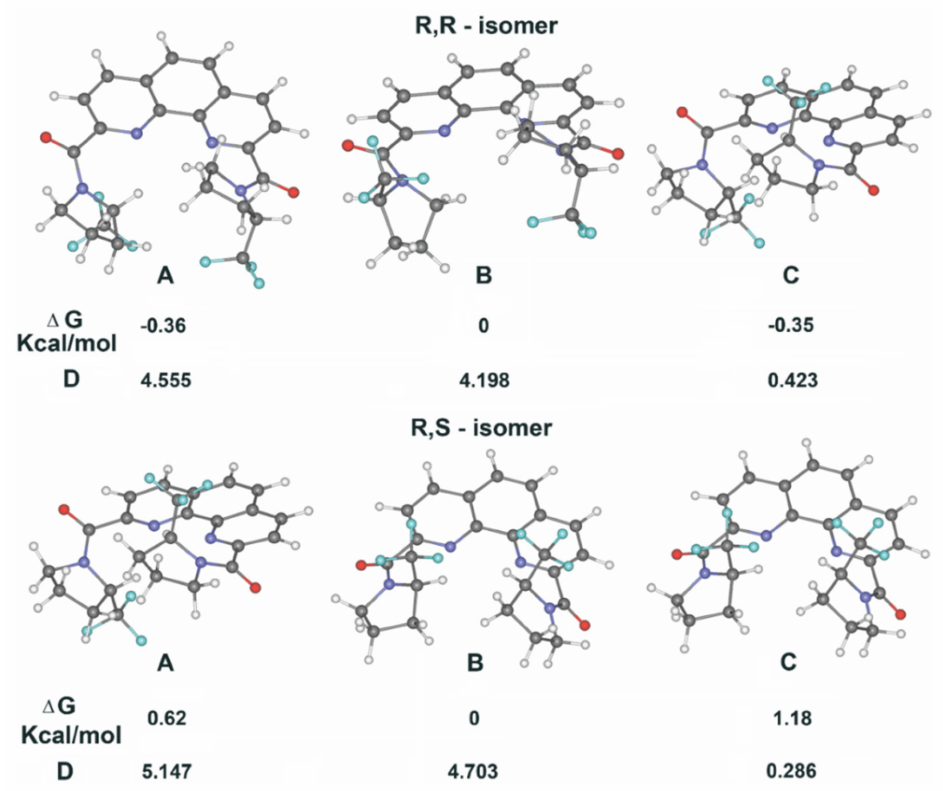
Figure 12. Calculated structures, energies and dipole moments in gas phase for rotamers of 1